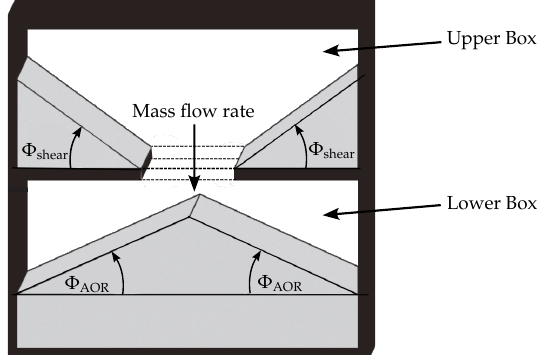
Figure 9. A typical draw-down test